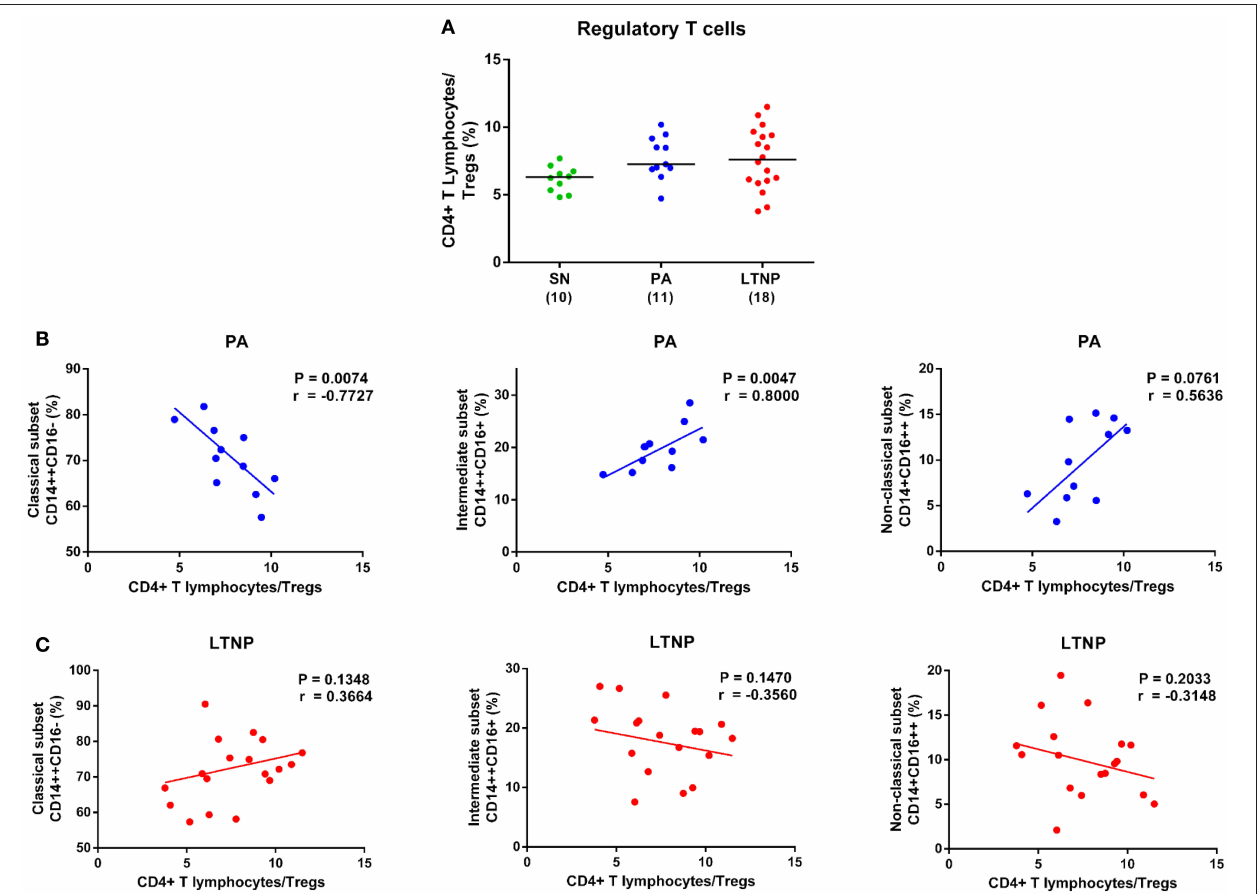
FIGURE 8 | Association of regulatory T cells with monocyte subsets in therapy-naïve cohorts. (A) Comparison of regulatory T cell (Treg) frequency in therapy-naïve groups (PA and LTNP) with seronegative (SN) controls. Kruskal-Wallis ANOVA followed by Dunn’s multiple comparison test was applied to assess significance. The expansion of regulatory T cell subset in both ART-naïve groups (PA and LTNP) compared to SN controls was significantly higher ( P < 0.05 for both) based on pairwise comparisons using unpaired t -test. (B,C) Association of Treg frequency with frequency of monocyte subsets in PA and LTNP groups, respectively. Association between variables was assessed using Spearman correlation analysis to determine correlation co-efficient “ r ” and test significance ( P <